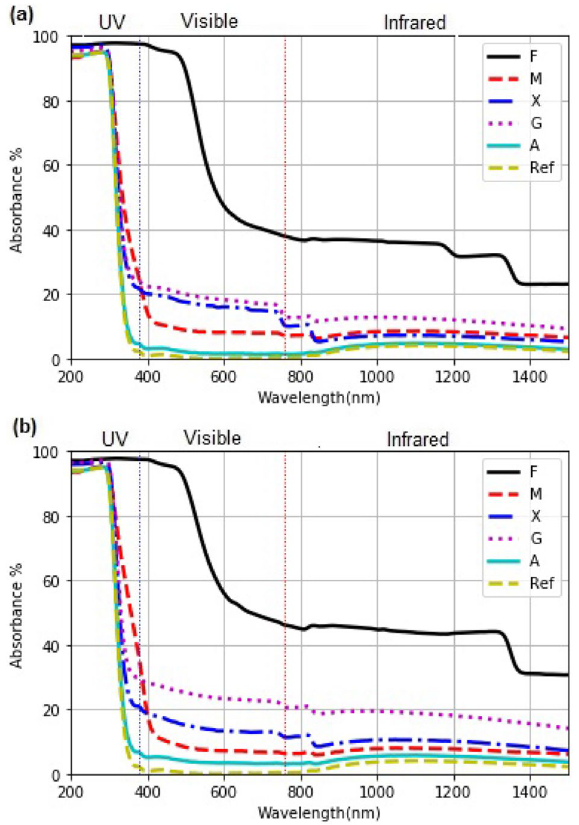
Figure 3. Percentage absorbance in the drop-cast coatings on glass slides made ( a ) 4 µ L and ( b ) 8 µ L of